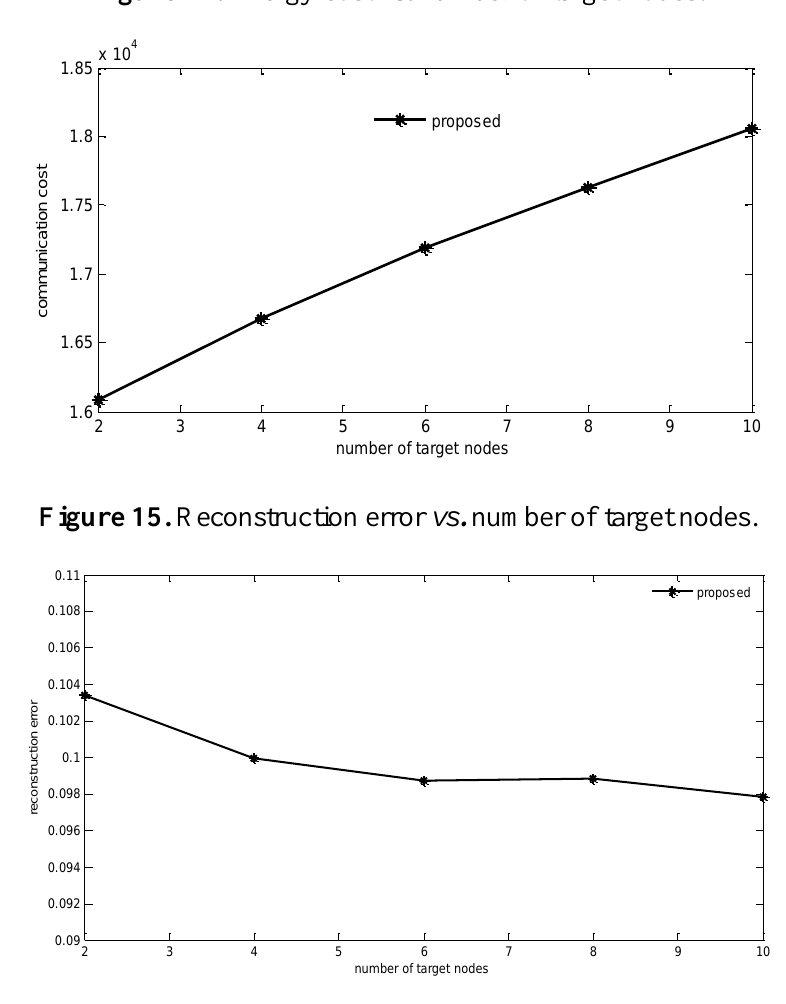
Figure 14. Energy cost vs. number of target nodes.